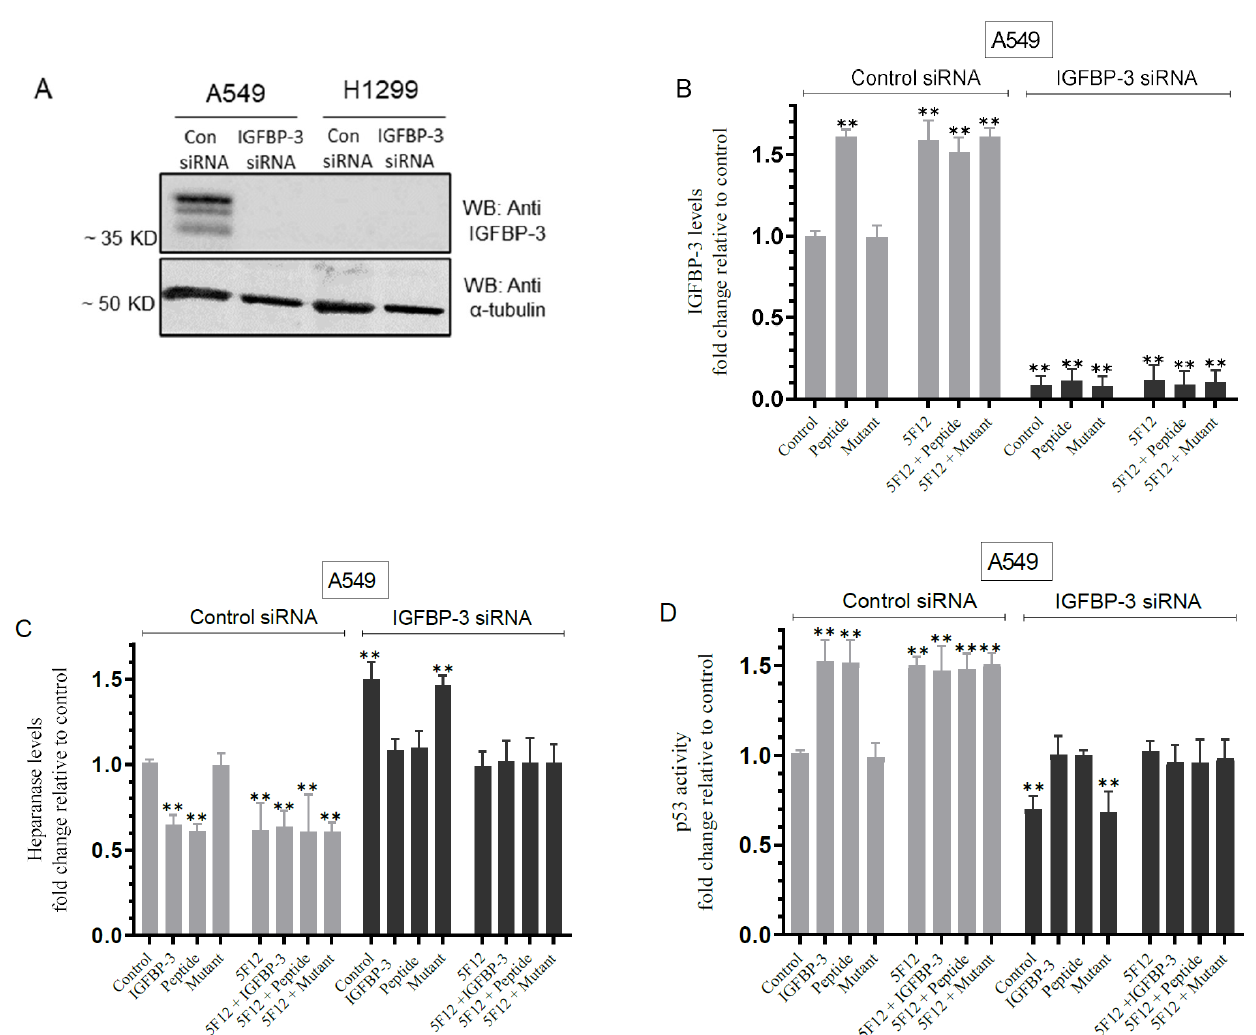
Figure 7. Knockdown of IGFBP-3 led to increased heparanase levels in the media of A549 cells and decreased p53 activity. Cells (0.2 × 10 5 ) were grown in 10% FBS-supplemented media for 24 h then serum starved overnight. The cells were then treated as indicated for 72 h with control siRNA or IGFBP-3 siRNA. The same concentration of total protein (15 µ L of 600 µ g/mL) of the cell lysates ( A ) was used for Western blotting using the indicated antibodies. As a loading con- trol, anti α -tubulin antibodies were used. Cell transfectants were treated without or with 50 nM IGFBP-3 protein/peptide/mutant, the CD44 antibody (5F12, 5 µ g/mL) added either separately or 2 h prior to addition of IGFBP-3 protein/peptide/mutant, or in combination ( B – D ). The media levels of IGFBP-3 ( B ) and heparanase ( C ) using the same amount of protein (3 µ L of 600 µ g/mL total protein), and the p53 activity in cell lysates ( D ) were measured as described in the Materials and Methods section. The graphs summarize the results expressed as means ± SD ( n = 5) using the GraphPad 9.4.1 software. Fold change was calculated relative to the A549 control siRNA transfectants (Control). Asterisks indicate a statistically significant difference from the corresponding A549 negative con- trol, Mann–Whitney test. Statistical differences between different groups were analyzed by a non- parametric Kruskal–Wallis test. Absence of asterisks indicates no significance, ** p <